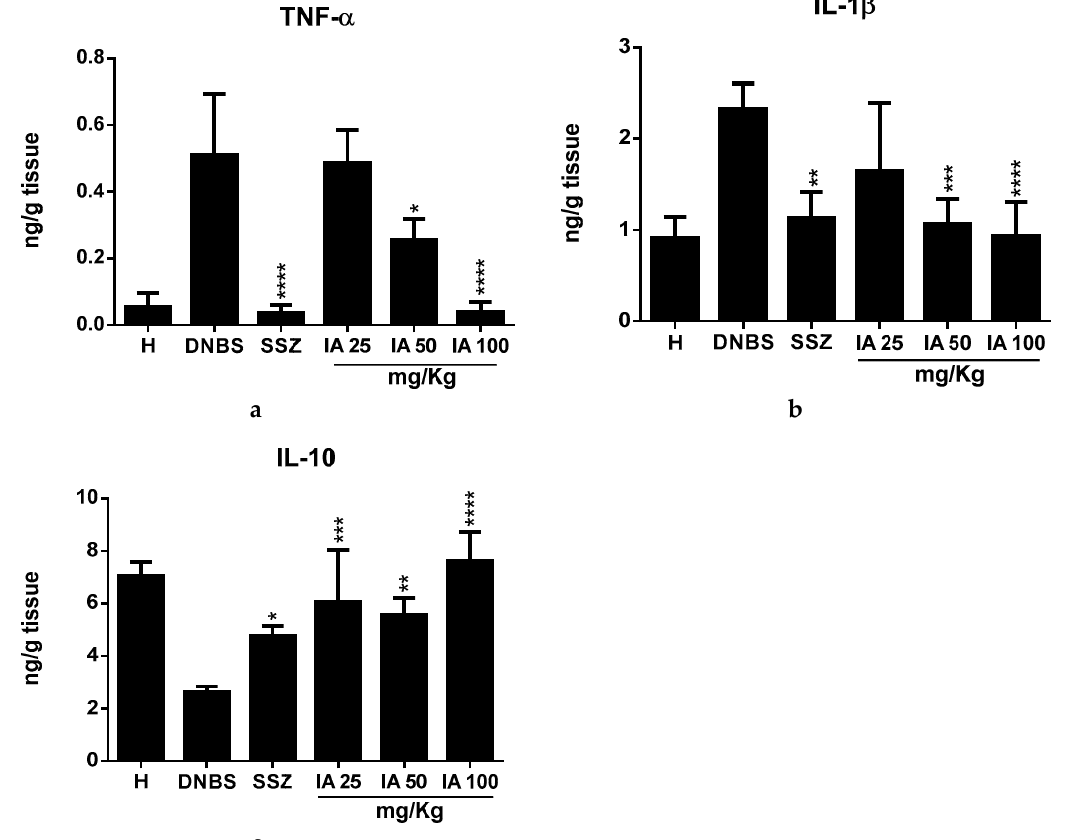
Figure 3. Effect of 25, 50, and 100 mg/kg doses of I. asarifolia (IA) aqueous extract, and 250 mg/kg sulfasalazine (SSZ) on the levels of cytokines, tumor necrosis factor α (TNF- α ) ( a ); interleukin-1 β (IL-1 β ) ( b ), and interleukin-IL10 (IL-10) ( c ) in the experimental trial of acute colitis induced by 2,4-dinitrobenzene sulfonic acid (DNBS) in rats. H, Healthy group; DNBS, DNBS group; SSZ, Sulfasalazine group; and 25, 50, and 100 mg/kg doses of IA. Data are expressed as mean ± SEM, ( n = 8). Statistical differences * p < 0.05, ** p < 0.01, *** p < 0.001 and **** p < 0.0001 of treatments vs DNBS control were presented.